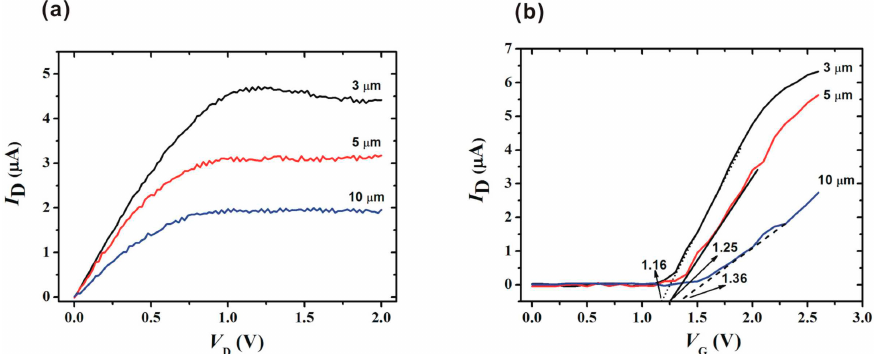
Figure 2. ( a ) I - V measurement for different fabricated poly-Si nanowires; ( b ) I D D Figure 2. ( a ) I D - V D measurement for different fabricated poly-Si nanowires; ( b ) I D - V G measurement for different fabricated poly-Si measurement for different fabricated poly-Si nanowires.